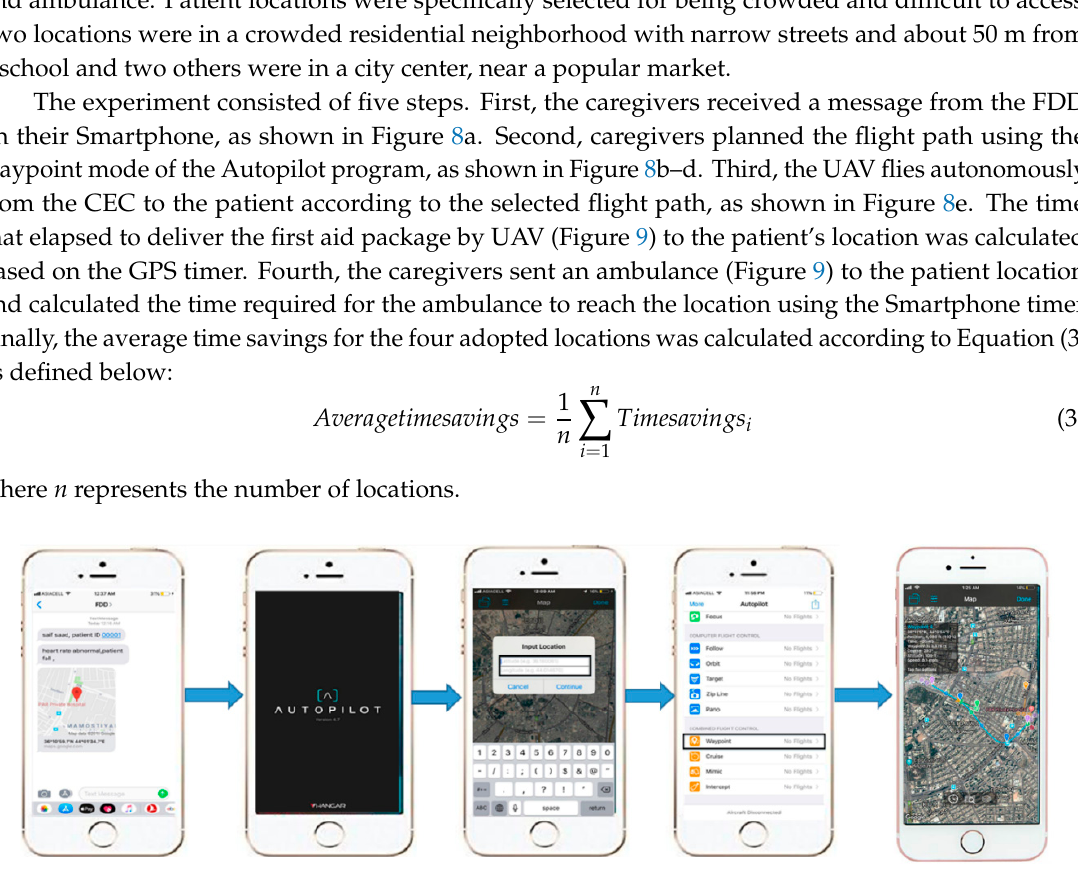
Figure 9. Time response experiment comparing the UAV and ambulance. 6. Results and Discussions The initial results of the experiments described above were encouraging. In this section, the results of each experiment are presented and validated separately. Drone First aid kit